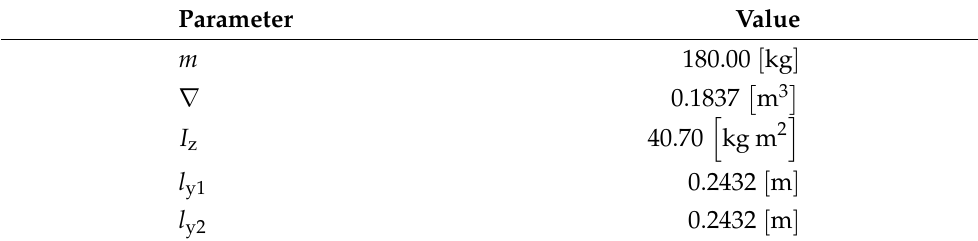
Table 1. Principal characteristics of the AUV.